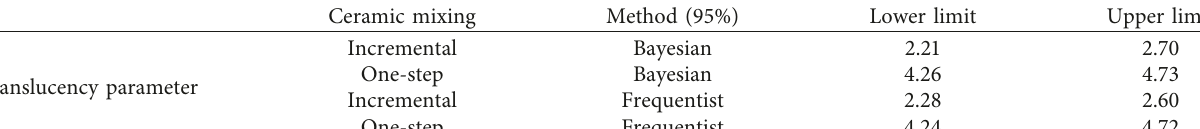
Table 1: Highest probability intervals for the incremental and one-step mixing methods.